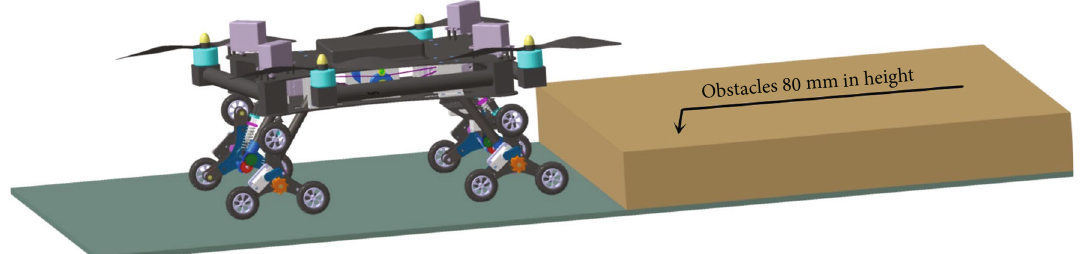
Figure 8: Limiting vertical obstacle